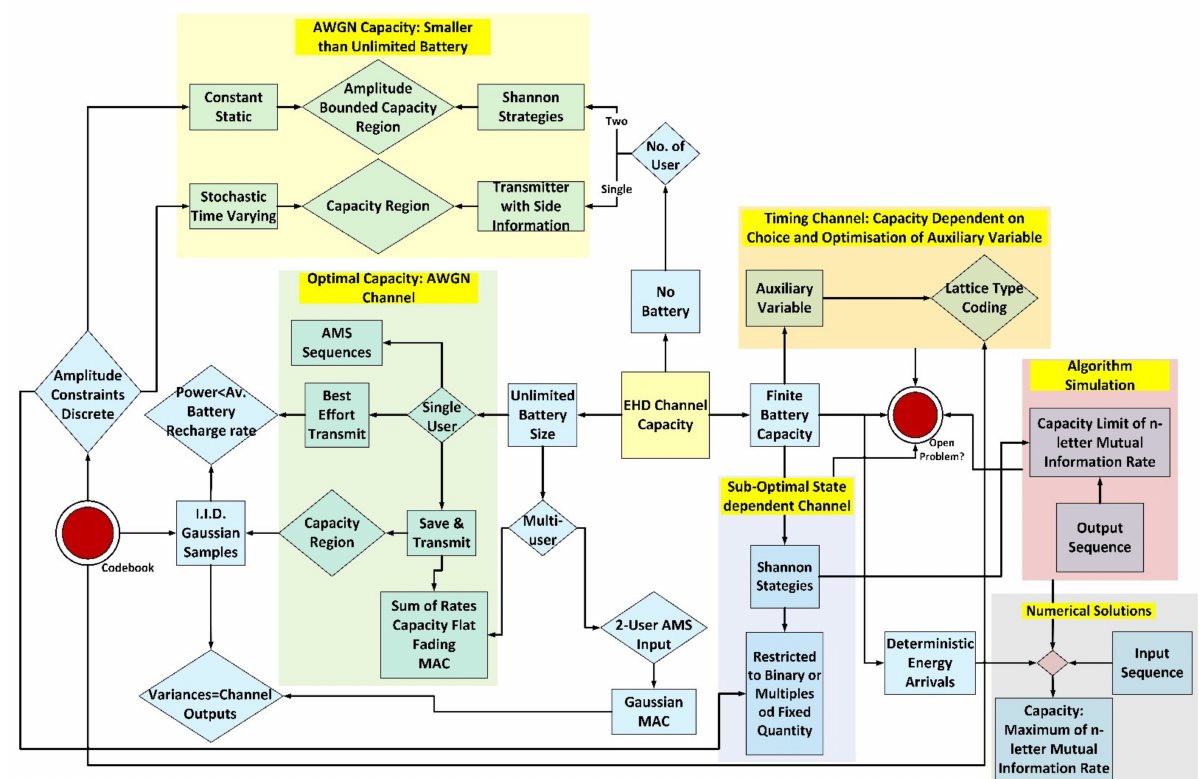
Figure 2. Schema of EHD channel capacity for three battery size